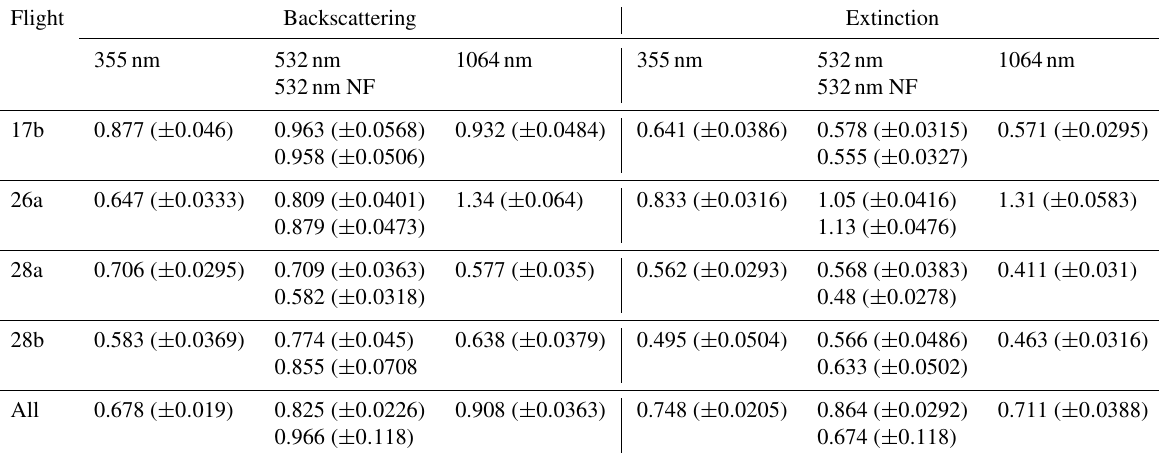
Table 1. Overview of the slopes and their standard error of a linear regression between the modeled extinction and backscattering coefficient with the measured ones from the lidar for the four investigated flights and summarized for all data points displayed, with the accuracy to three significant figures. Flight Backscattering